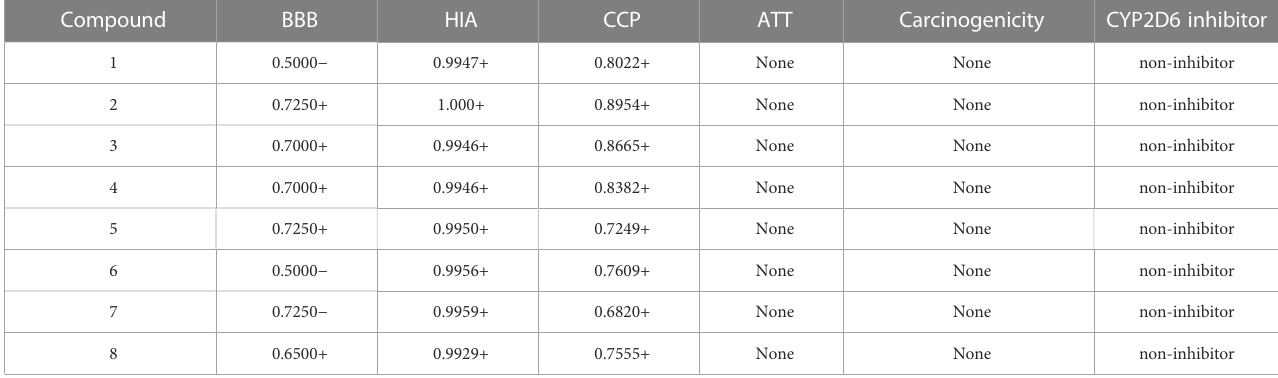
TABLE 4 ADMET prediction results for compounds.